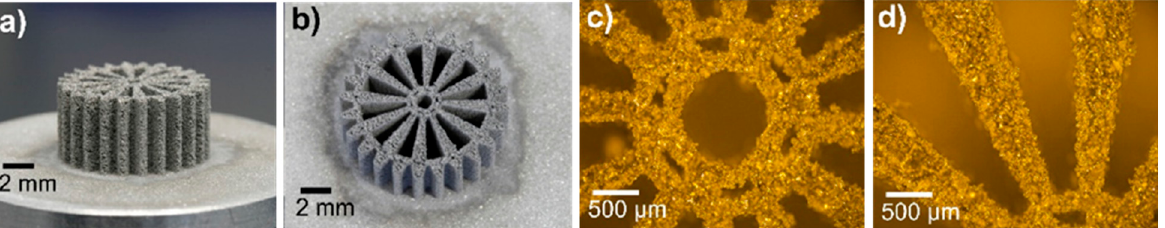
Figure 23. Lithium content versus density and Young’s modulus in Al–Li alloys [60].